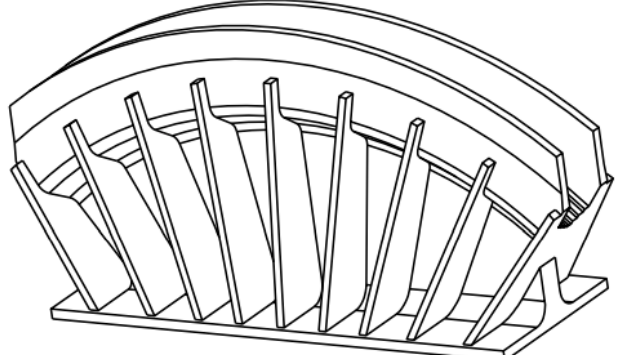
Figure 2. Perspective view of cable saddle.